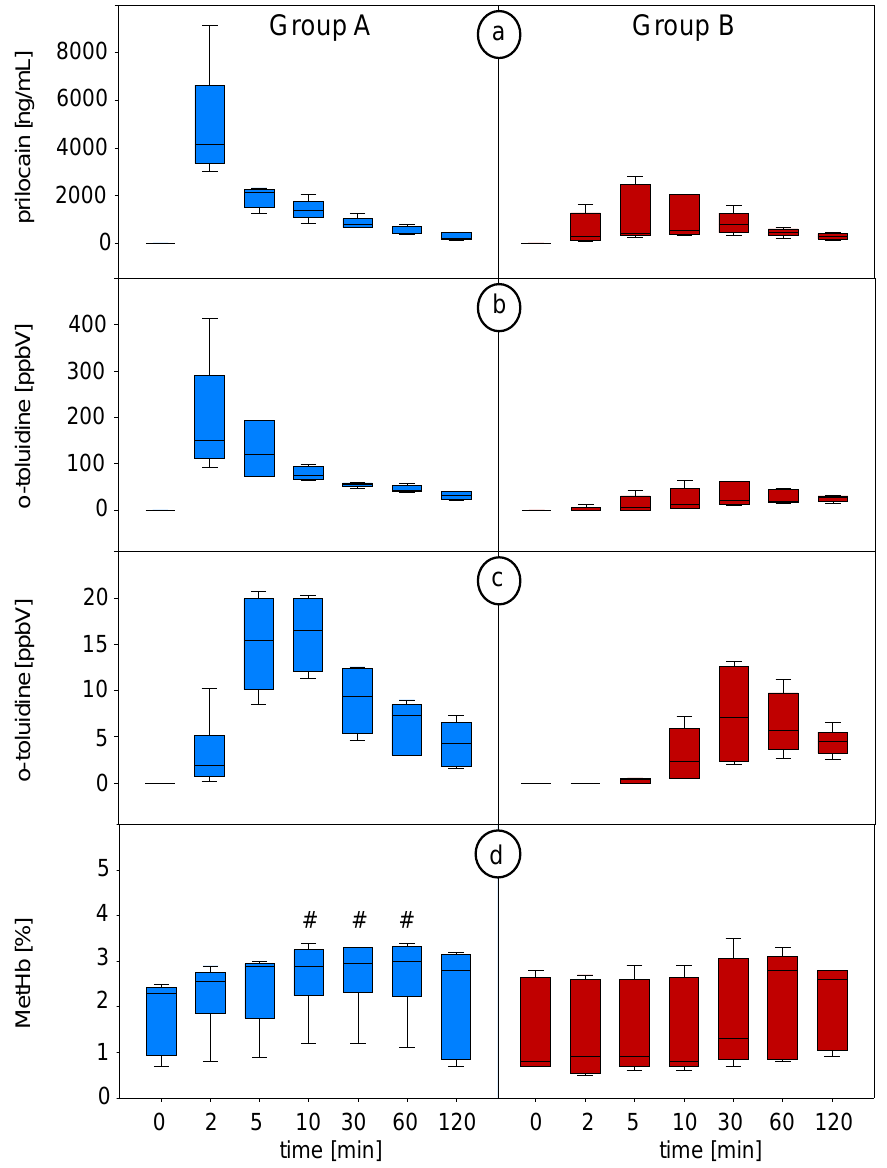
Figure 3. ( a ) Prilocaine concentrations in blood measured by means of GC-MS, ( b ) o-toluidine concentrations in the headspace over blood measured by means of SPME-GC-MS and ( c ) o-toluidine concentrations in breath measured by means of PTR-ToF-MS at defined timepoints (breath data from continuous measurement were averaged over the corresponding minute). ( d ) Percentage values of methaemoglobin (MetHb) related to haemoglobin (Hb) during the experiment. # indicates statistically significant changes in MetHb versus P0 (0 min) (repeated measures ANOVA on ranks, Dunn’s post hoc test and p < 0.05 was considered significant). Blue plots represent group A (intravenous injection of prilocaine), and red plots represent group B (cervical plexus regional anaesthesia with prilocaine). P0: before prilocaine injection; P1: 2 min; P2: 5 min; P3: 10 min; P4: 30 min; P5: 60 min; P6: 120 min after prilocaine